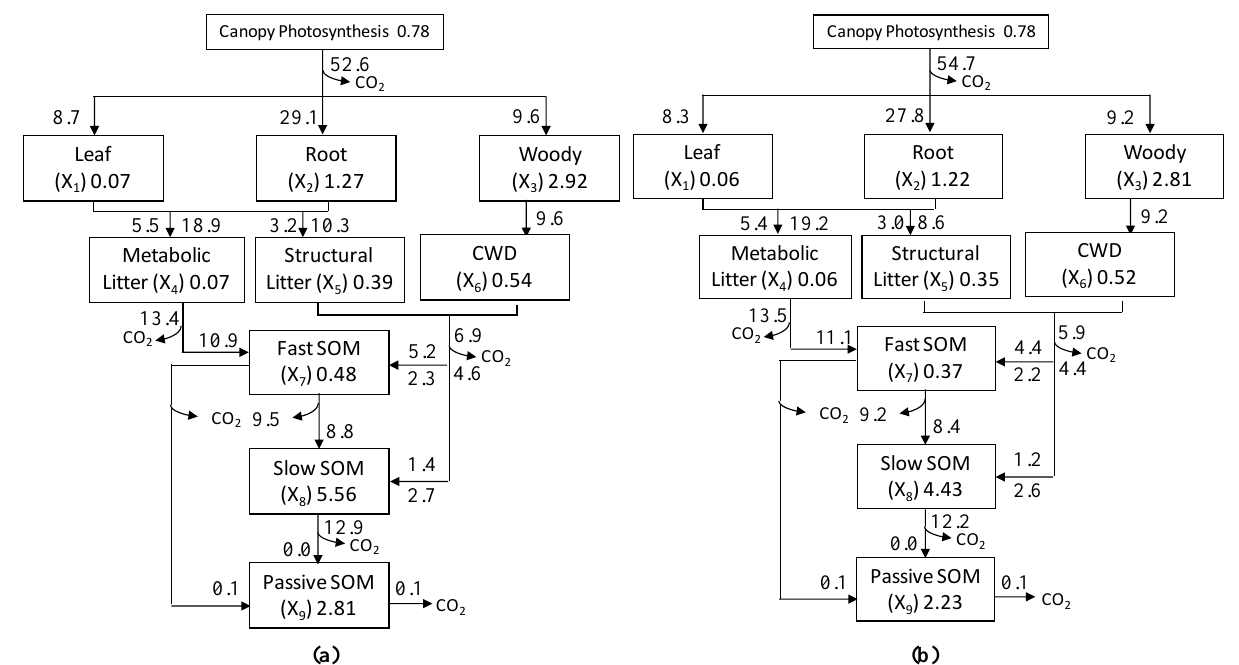
Fig. 7. Structure of CASACNP model for (a) carbon-only and (b) coupled carbon–nitrogen simulations on which Eq. (1) is based. The fraction of carbon that flows through differential pathways (the numbers near the arrows) is partitioned to the 9 pools. The numbers in the boxes are steady states of ecosystem carbon influx (kgCm − 2 yr − 1 ) and pool size (kgCm − 2 ) . The fraction to plant pools is determined by partitioning coefficients in the vector B in Eq. (1). The fractions to litter and soil pools are determined by the transfer coefficient matrix A in Eq. (1). The values of B and A are the global mean values at steady states. SOM stands for soil organic matter. Upper and bottom values near the arrows represent fractions from structural litter and coarse wood detritus (CWD), respectively.